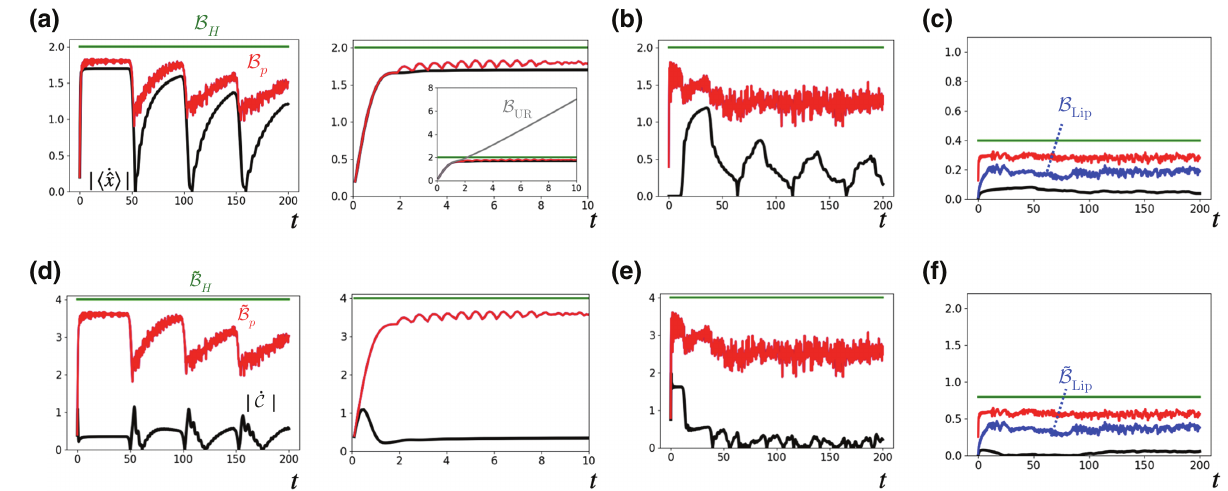
(cid:3)˙ˆ FIG. 5. (a)–(c) Speed of the position, x (cid:4) (black), and the speed limits for the initial states (a) | ψ 1 (cid:4) (the right panel shows the short- time regime), (b) | ψ 2 (cid:4) , and (c) | ψ 3 (cid:4) in a single-particle system. The bounds are given by B Lip in Eq. (42) (blue), B p in Eq. (45) (red), and B H in Eq. (48) (green). In the inset of the right panel of (a), we also show the bound B UR based on the uncertainty relation in Eq. (2) (gray). Our bounds are not divergent with L and t even for long times and become much tighter than B UR . Furthermore, the bounds typically become tighter in (c) than in (a) and (b), since E trans is larger. We note that the data for B Lip and B p overlap for (a) and (b). ˙ C | defined in Eq. (80) (black), and the speed limits for the initial states (d) | ψ 1 (cid:4) (d)–(f) Speed of the macroscopic coherence measure | ˜ B ˜ B ˜ B (the right panel is for short times), (e) | ψ 2 (cid:4) , and (f) | ψ 3 (cid:4) . The bounds are given by Lip in Eq. (81) (blue), and p (red) and H (green) in Eq. (54). We again find that each speed limit provides a physically reasonable bound, which does not diverge with L and t . We use K = 1, W l = 0, L = 100, and M =